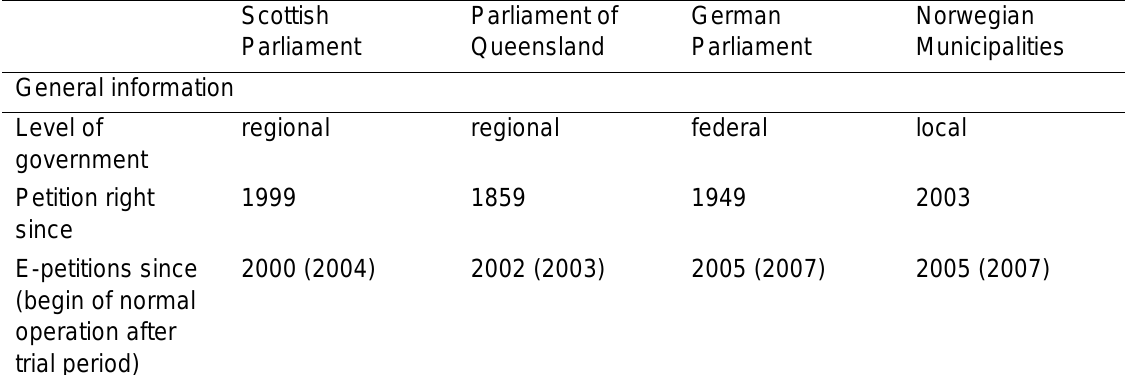
Table 1: Formal E-Petition Systems in Comparative